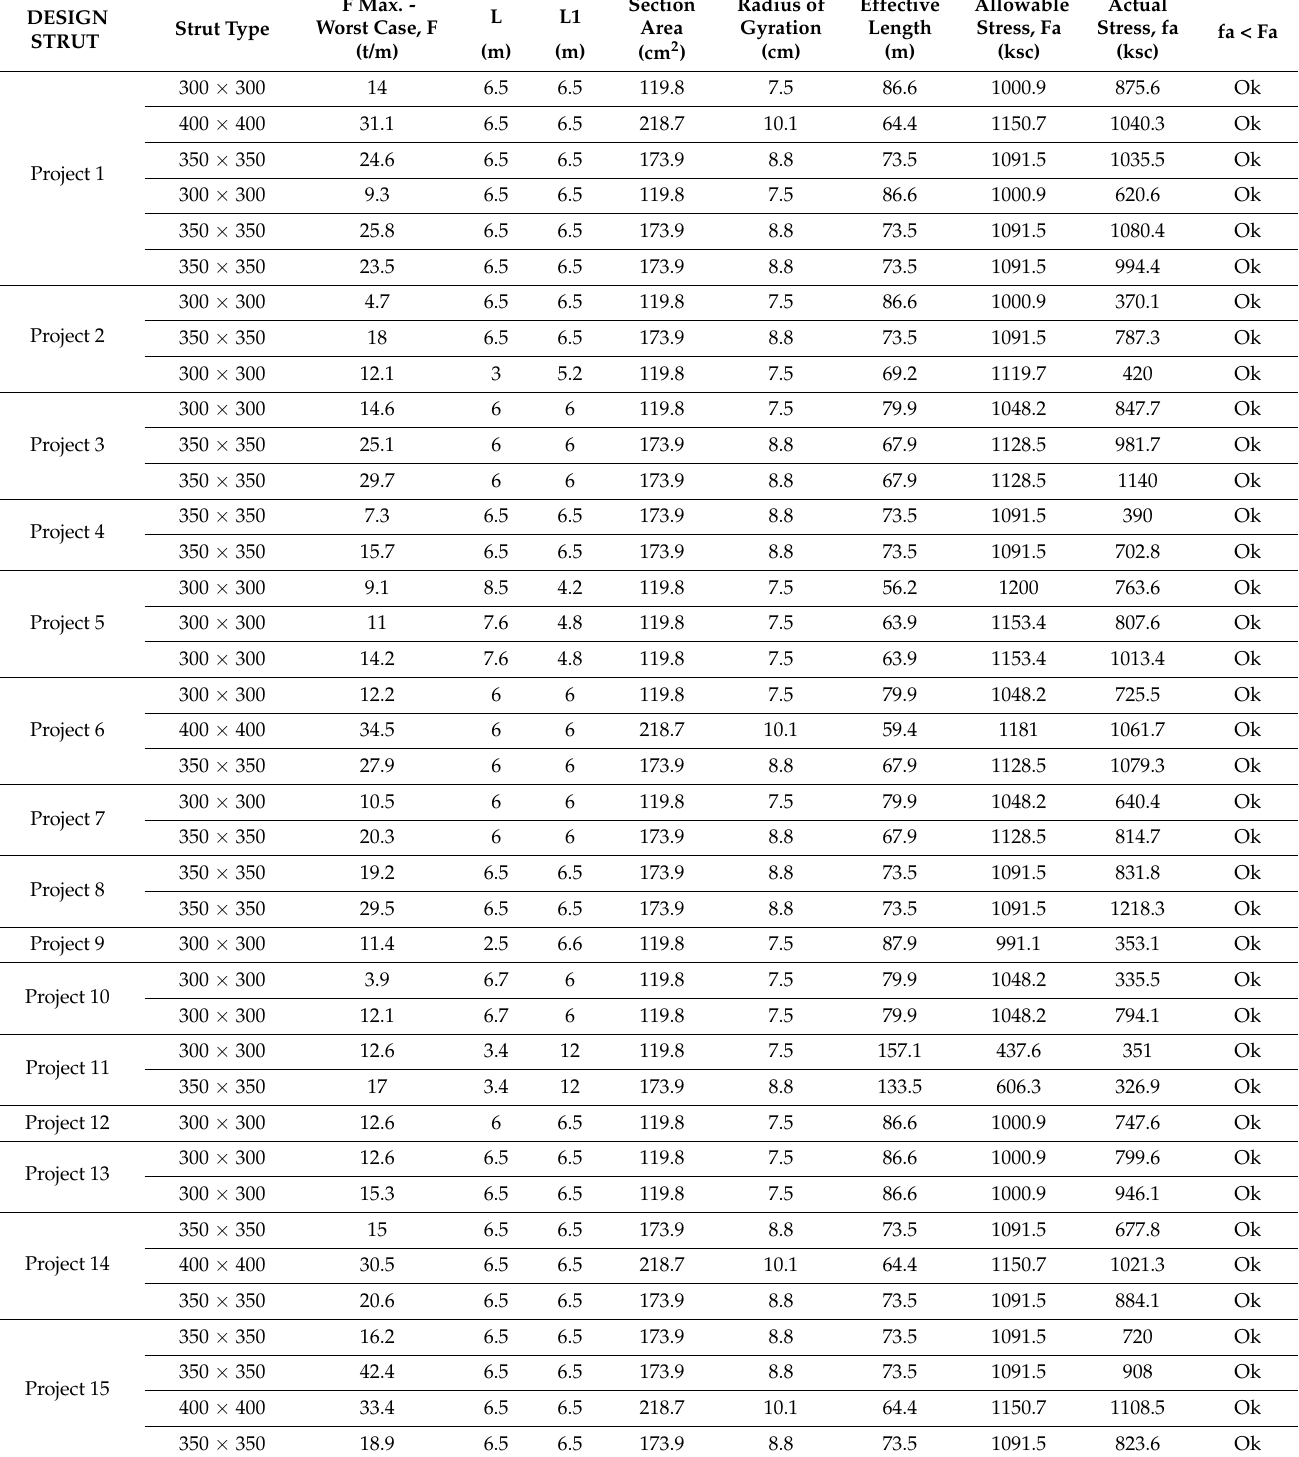
Table 4. Allowable spacing numbers (L) from 25 deep excavation